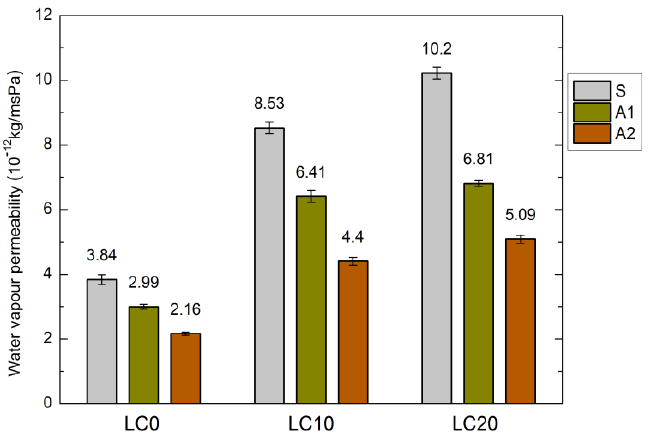
Figure 3. Water vapor permeability of LC before and after hydrophobization (10 −12 kg/msPa).